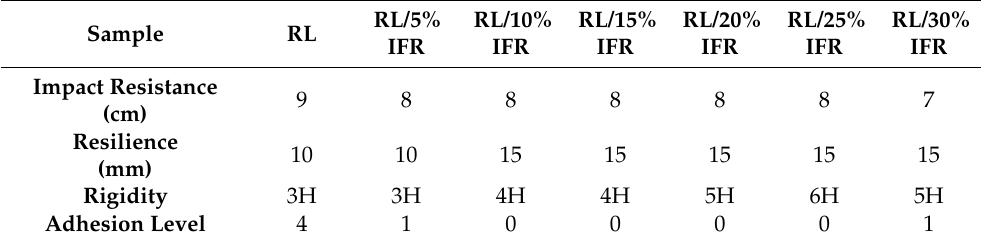
Table 4. Mechanical properties of RL/IFR membranes.